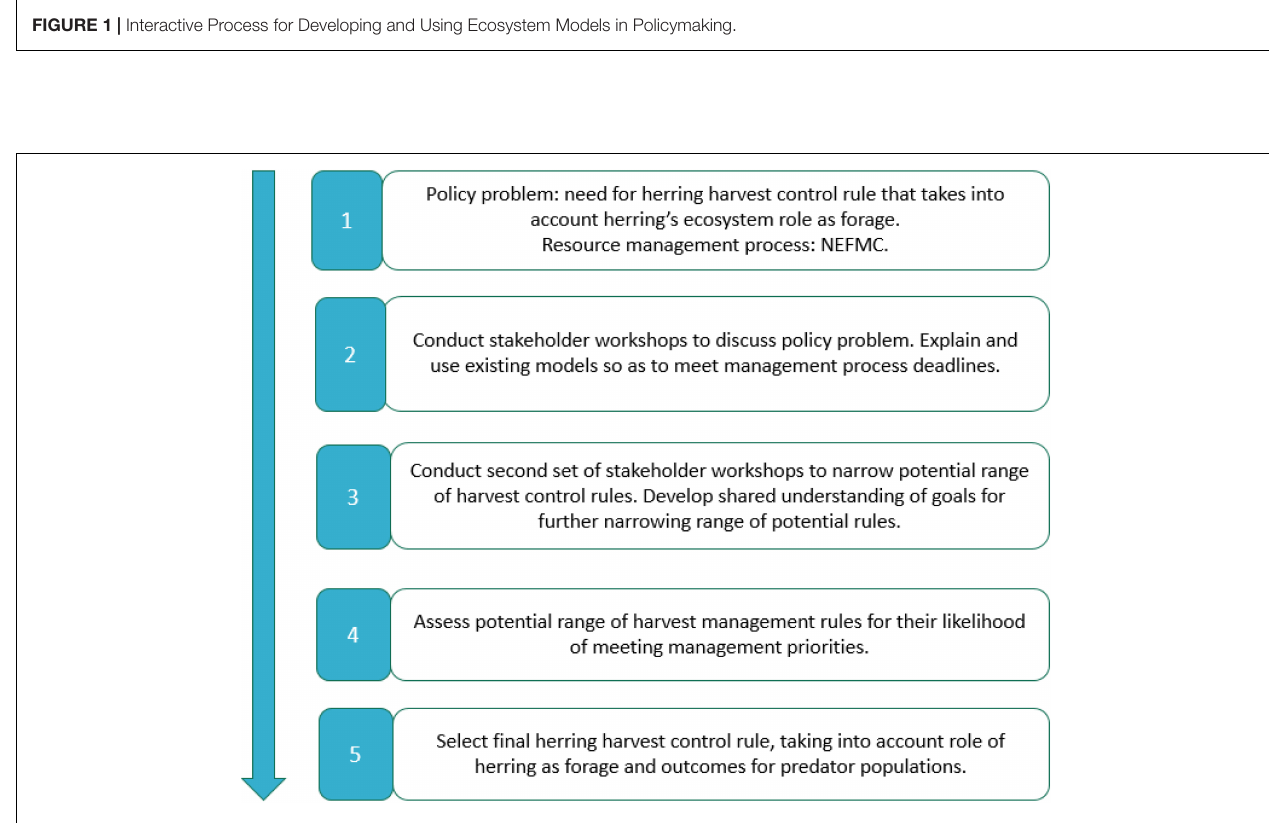
FIGURE 2 | Atlantic Herring Case Study